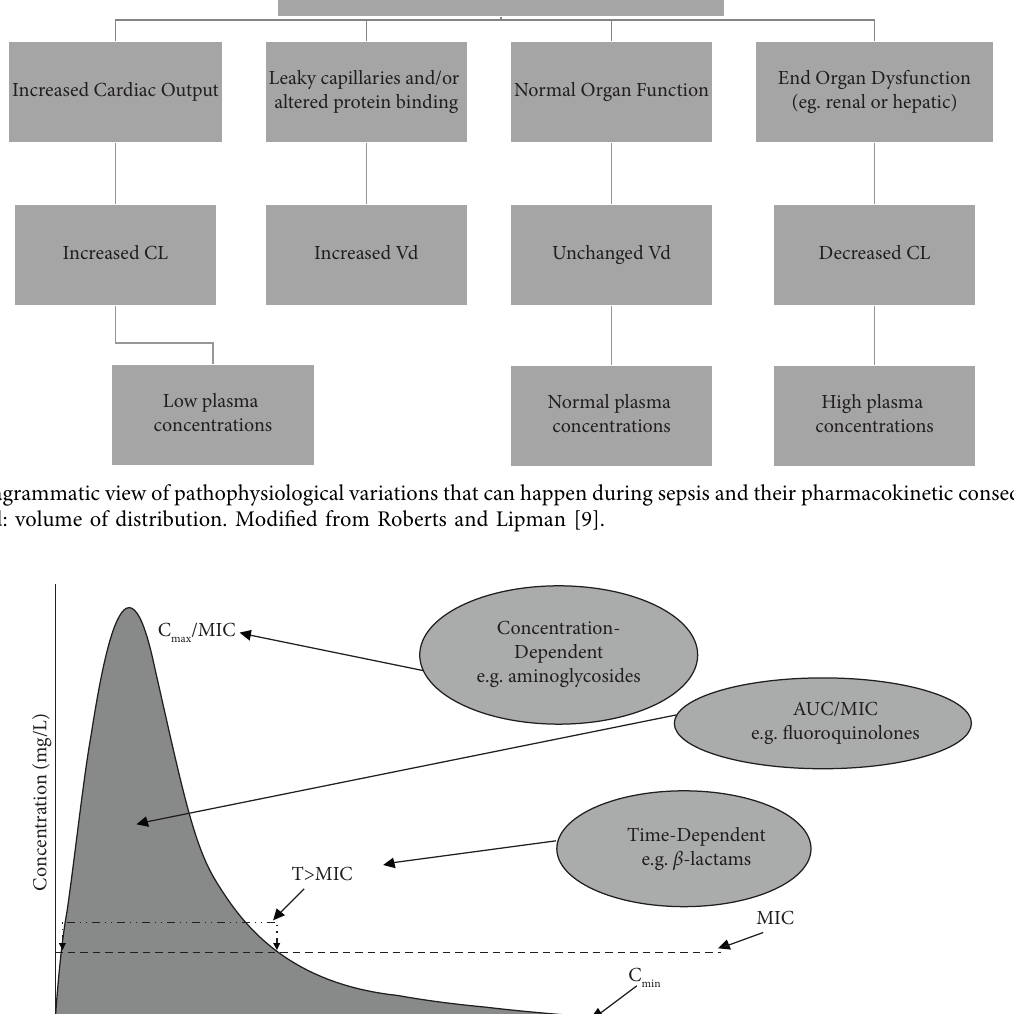
max /MIC: maximum